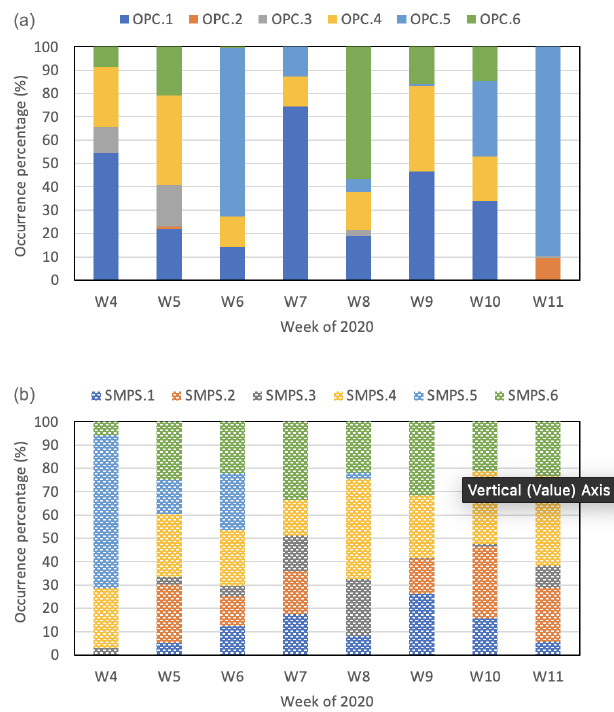
Figure 7. Weekly contribution (week number refers to week of year 2020) of the clusters formed by the OPC (a) and SMPS (b)